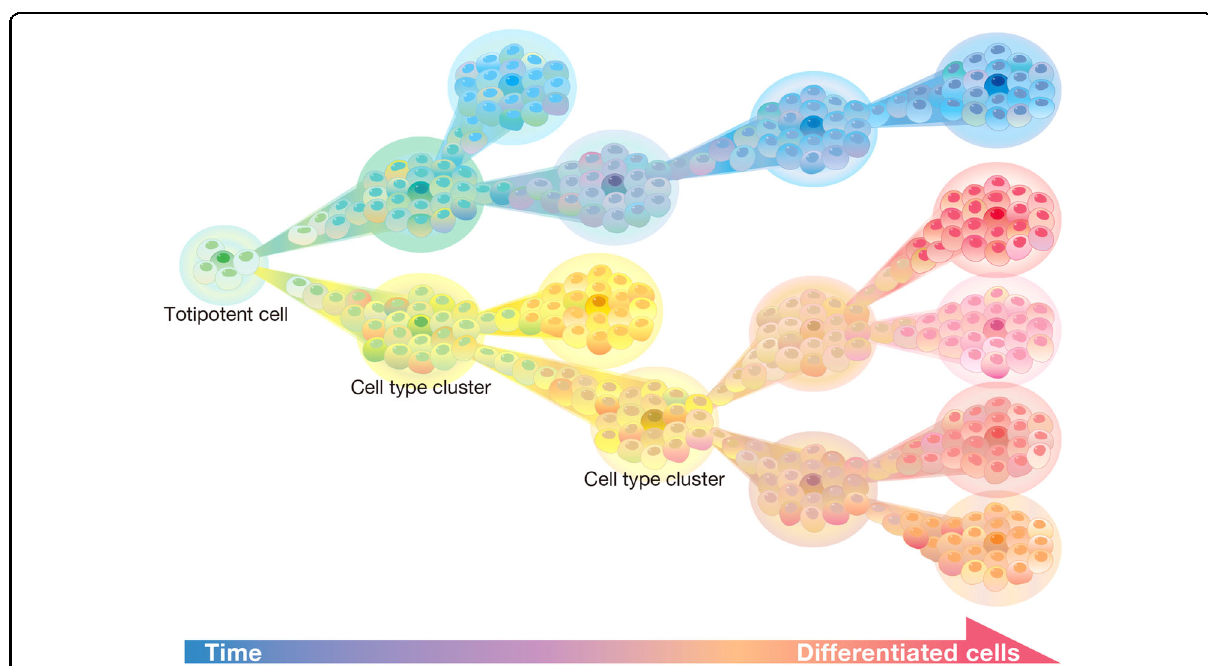
Fig. 1 Renewed concept of cell types that takes into account the cell state continuum and diversity, as well as the state stability, of a cell type. Classically, the continuum was thought to be unidirectional, but cell reprogramming induces cells to regress to a previous state and/or take a different